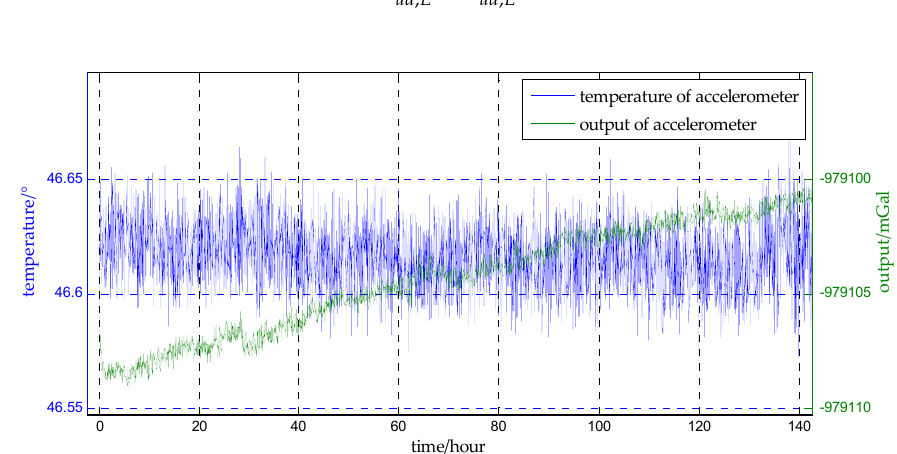
Figure 10. Comparing the temperature of the accelerometer with the output of the accelerometer.